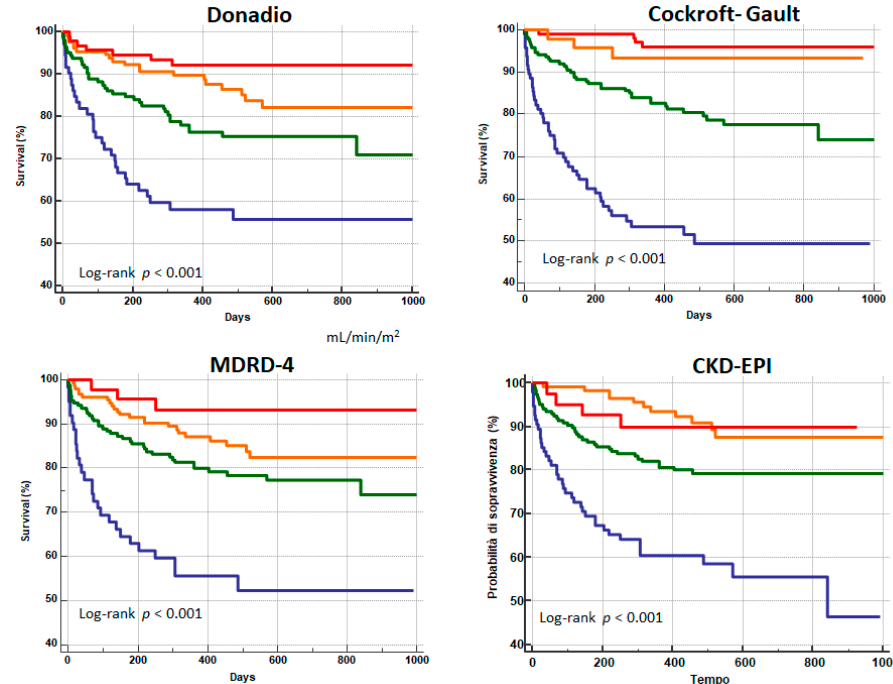
the curve; CKD-EPI: Chronic Kidney Disease Epidemiology Collaboration; MDRD-4: Modification of Diet in Renal Disease Study.